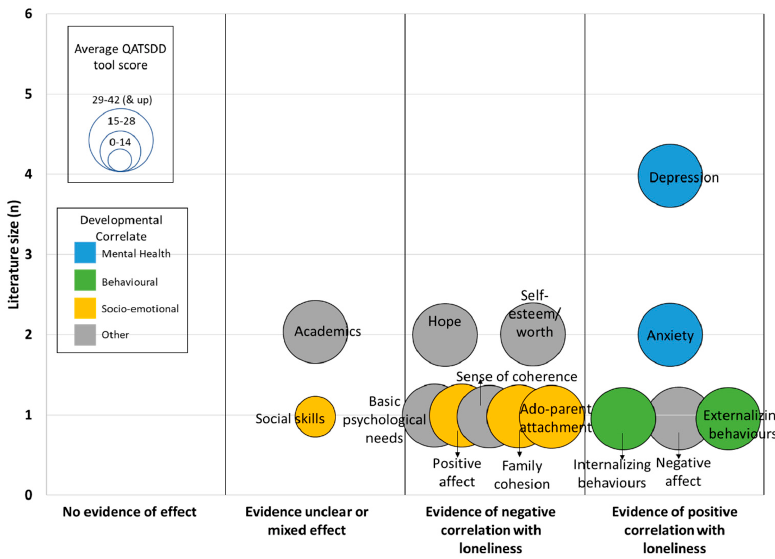
Figure 2. Evidence map of the literature on the effects of loneliness in children with neurodevelopmental disabilities (NDD).